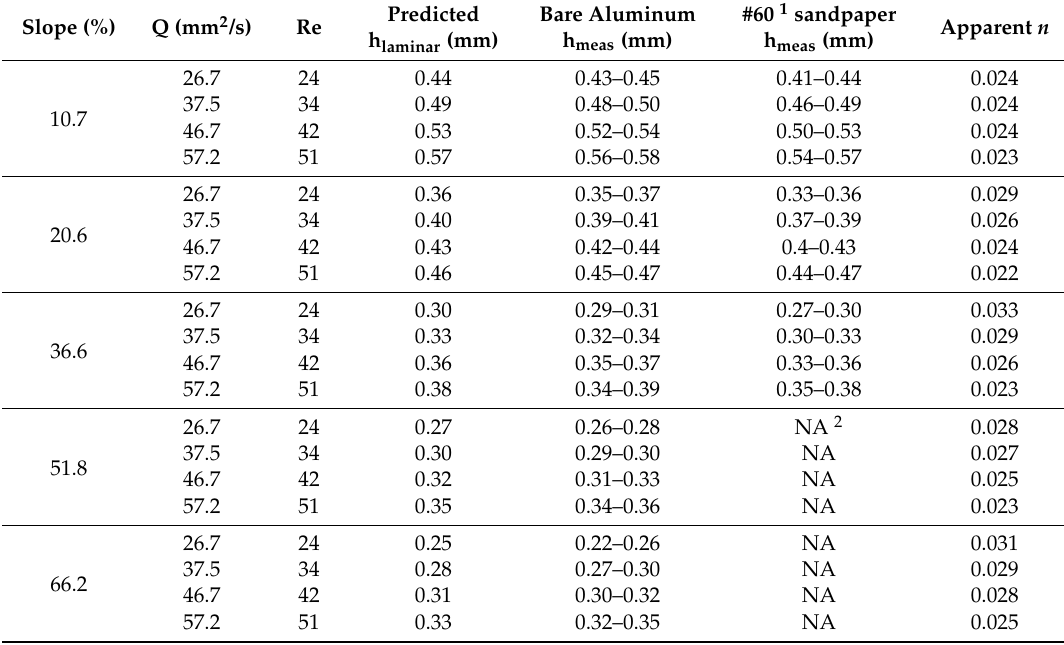
Table 1. Sheet flow average depth measurement results (water temperatures of 16–17 ˝ C). Slope